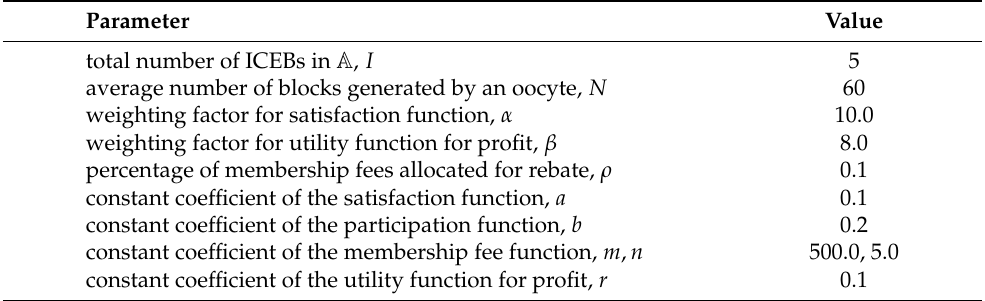
B B B B B 2 3 5 1 4